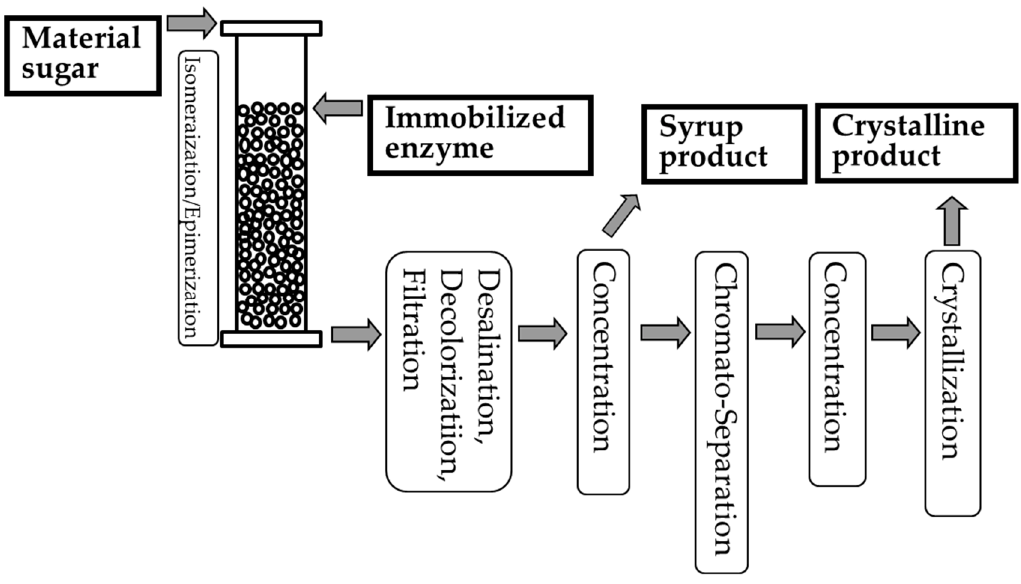
Figure 4. Schematic diagram of hexose production using immobilized enzymes.